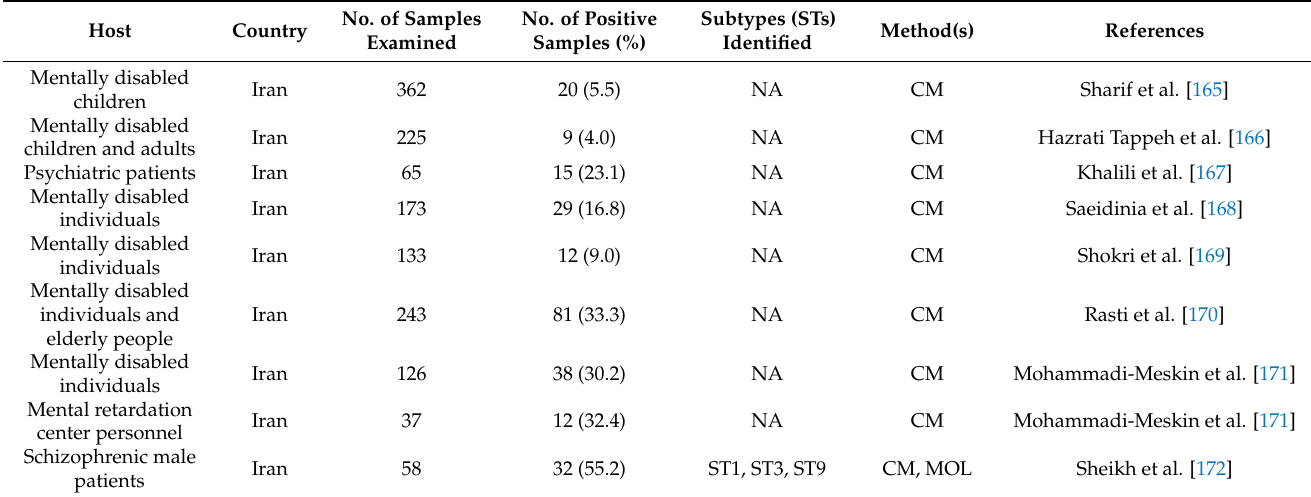
Table 4. Prevalence and subtype distribution of Blastocystis spp. in mental rehabilitation centers in Asia